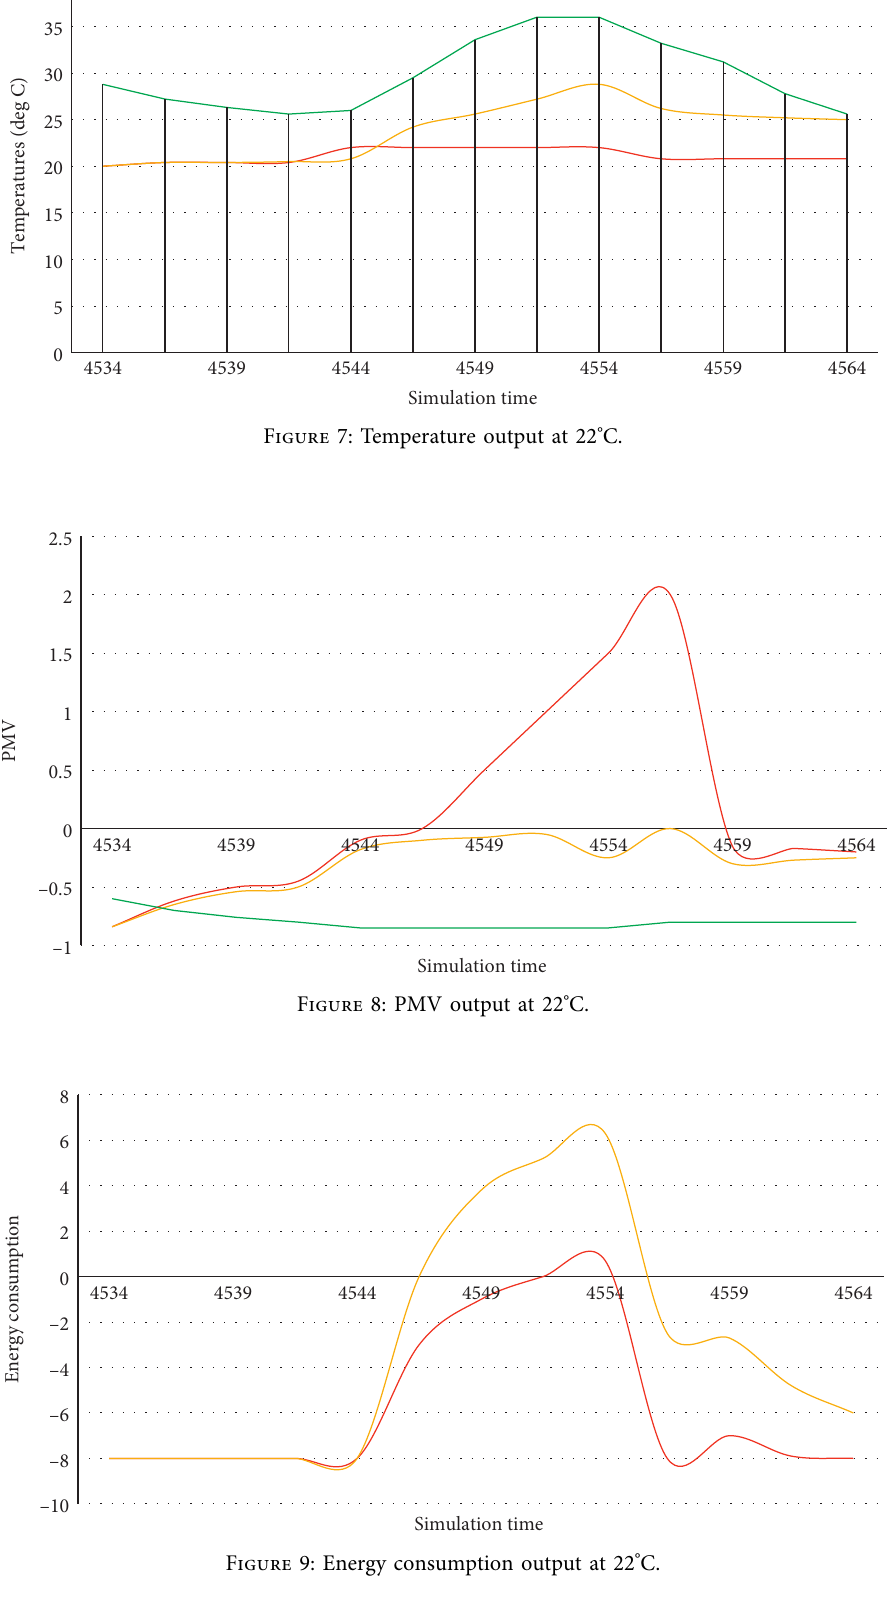
Figure 9: Energy consumption output at 22 °